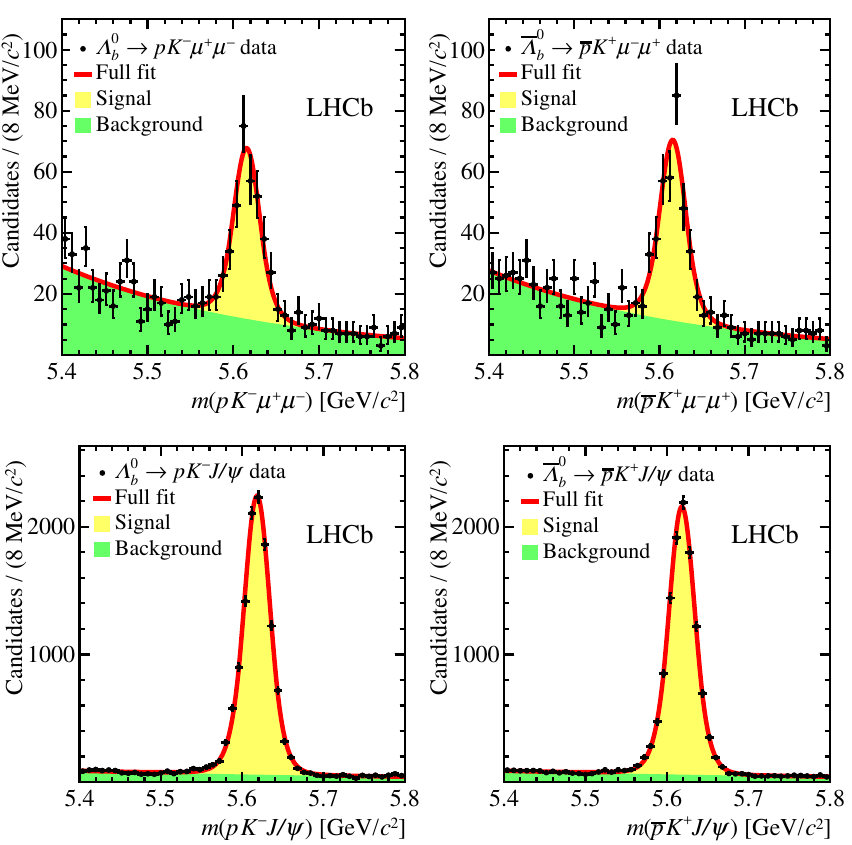
Figure 3 . Invariant mass distributions of (top) (cid:3) 0 candidates, with (cid:12)t results superimposed. Plots refer to the (left) (cid:3) 0